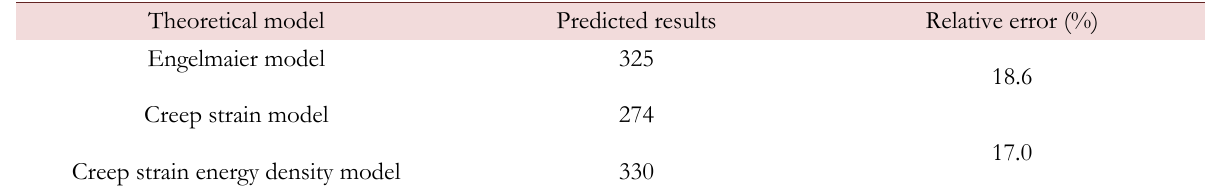
Table 3: The predicted fatigue life of the TIM2 layer in SiC-IGBT power module